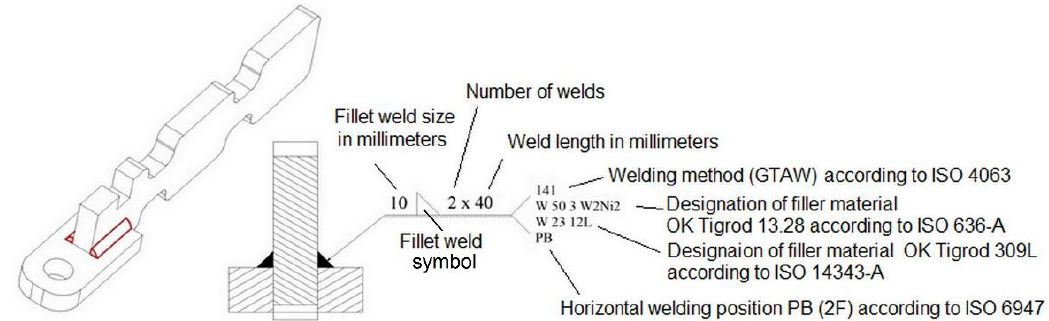
tional GMBH, Wels, Austria. Job welding equipment in accordance with Figure 9.